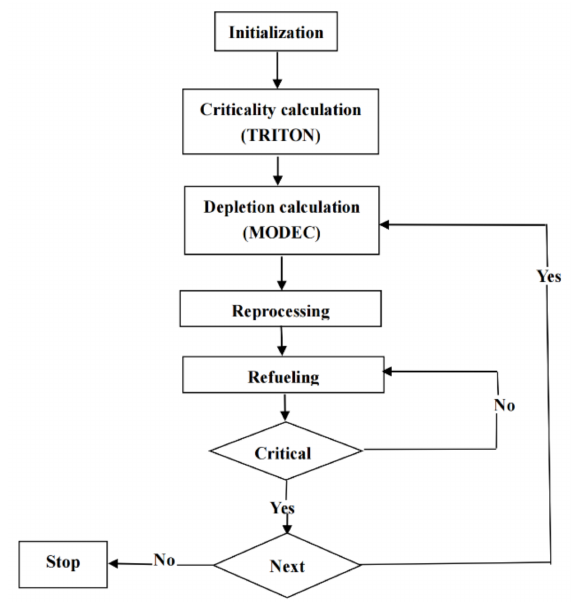
Figure 3. Flowchart of